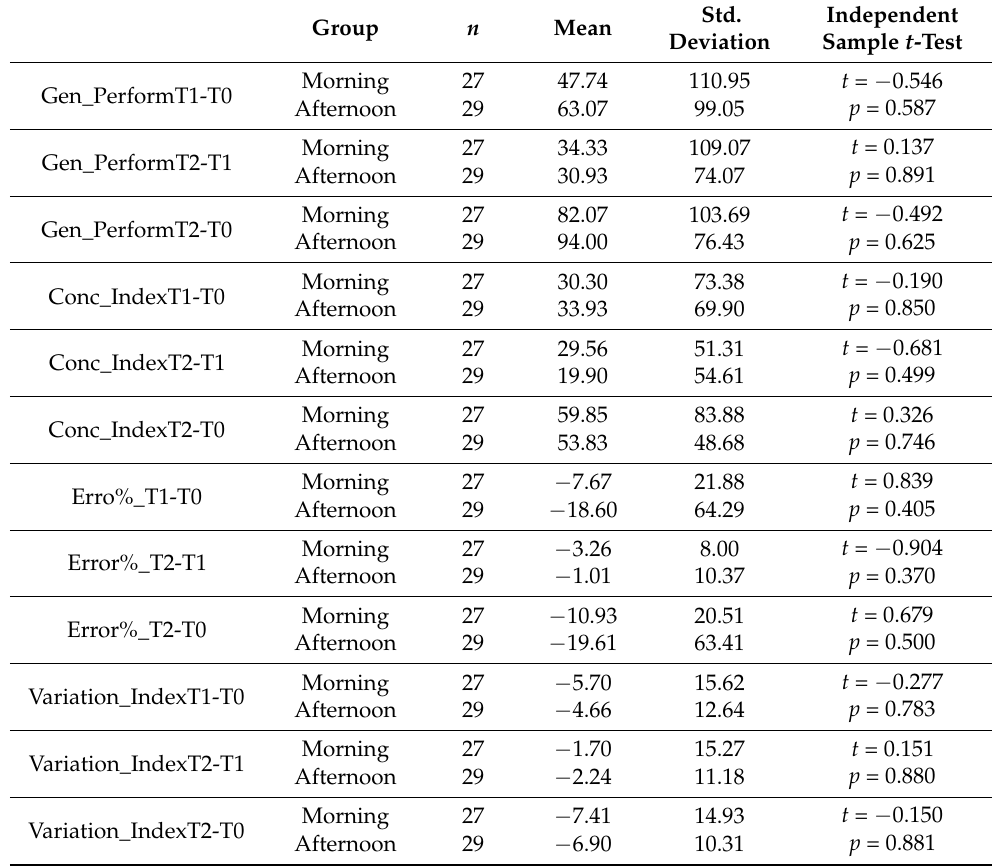
Table 2. Independent samples t-test: Comparison of the 2 groups (M vs. A) in the Relative